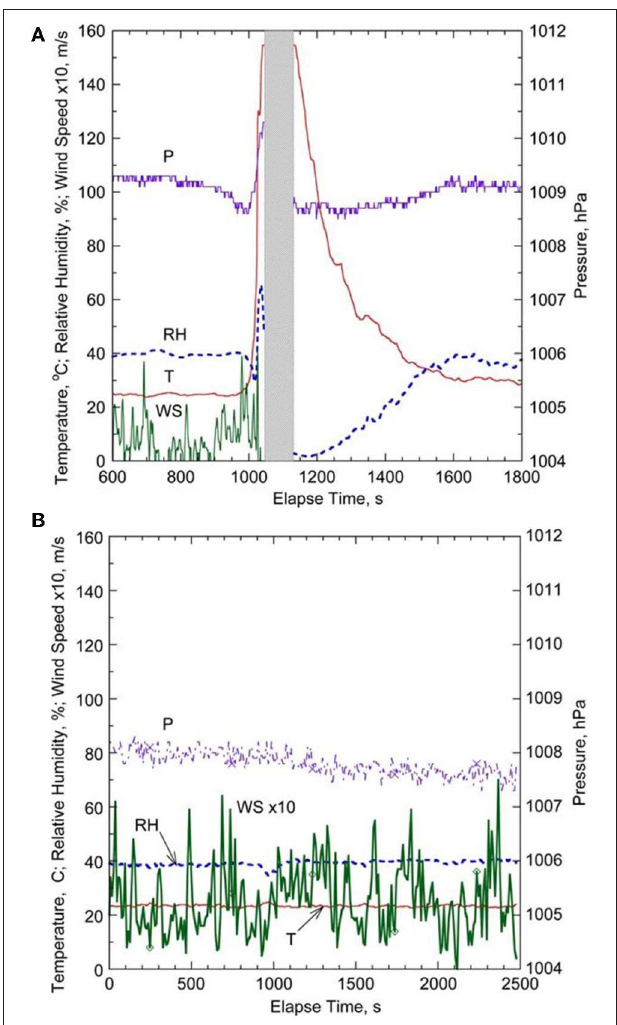
FIGURE 11 | Measured air temperature, pressure, relative humidity, and wind speed. (A) At 2m (6.6 ft) above the ground near the structure entrance (see a cup anemometer in Figure 9A ) and (B) at 1.4m (4.6 ft) above the ground at the roadside of the west fire